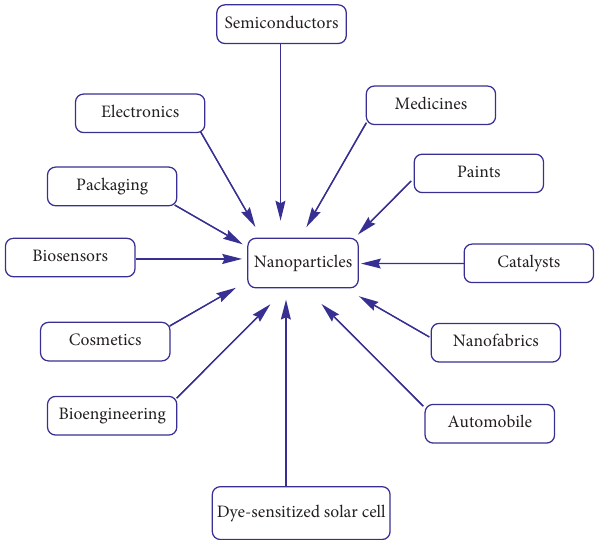
Figure 1: An overview of applications of nanoparticles [9].